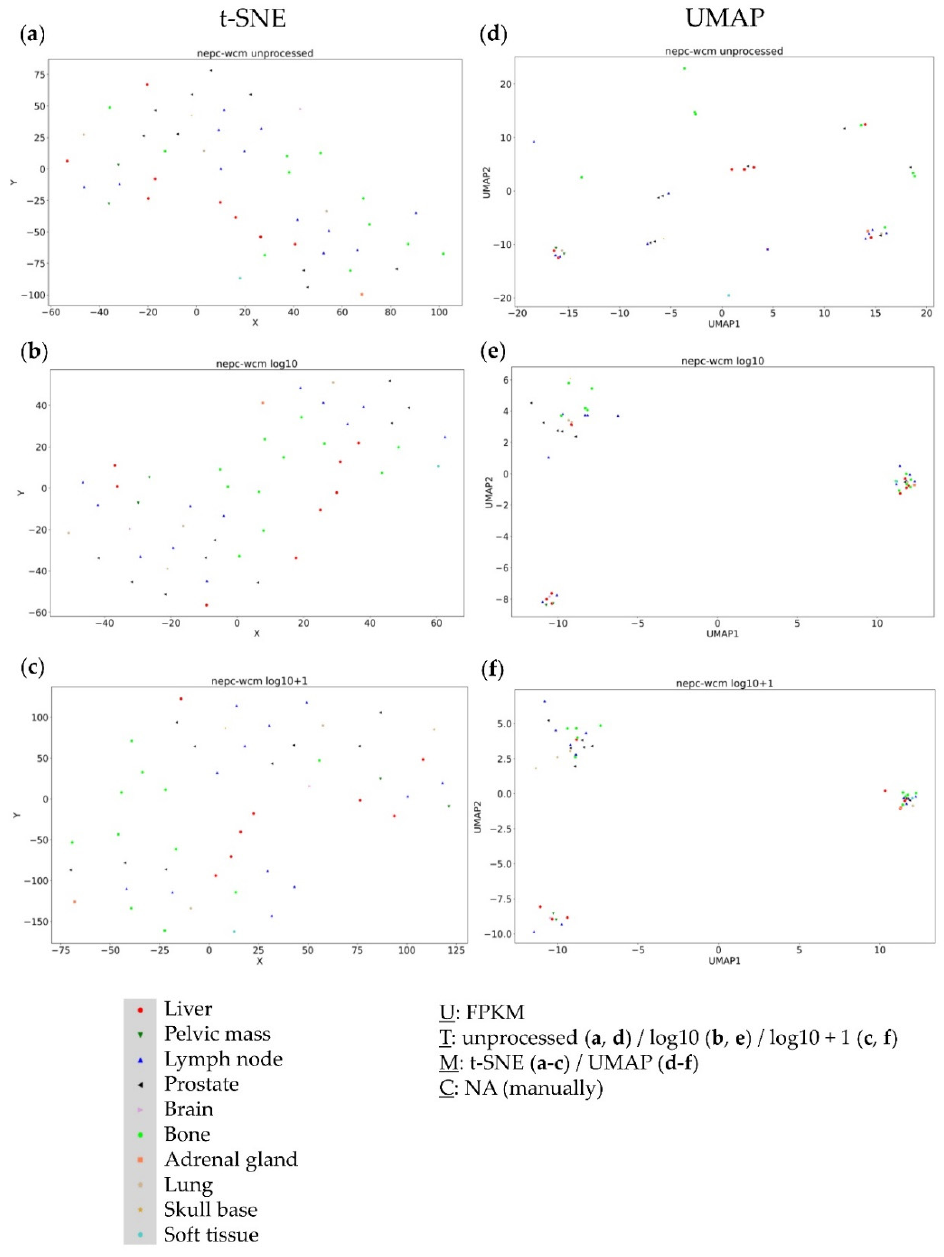
Figure 2. Visual clustering of the NEPC WCM dataset consisting of neuroendocrine metastatic prostate cancer (with respective resection sites) by applying different data dimension reduction methods. t-SNE plot approach for ( a ) unprocessed, ( b ) log10 transformed, and ( c ) log10 + 1 transformed FPKM values and UMAP approach using ( d ) unprocessed, ( e ) log10 transformed, and ( f ) log10 + 1 transformed FPKM values. FPKM: Fragments Per Kilobase Million; U: unit, T: transformation, M: data dimension reduction method, C: clustering method, NA: not